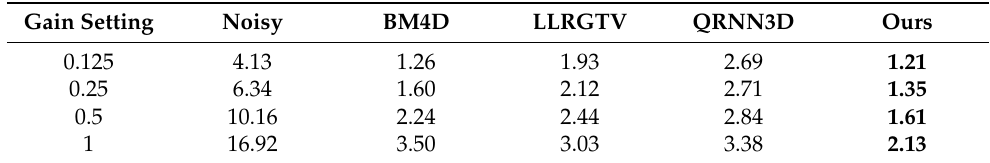
Table 2. Results of the ERGAS for the different methods on data with various gain settings (best results are highlighted in